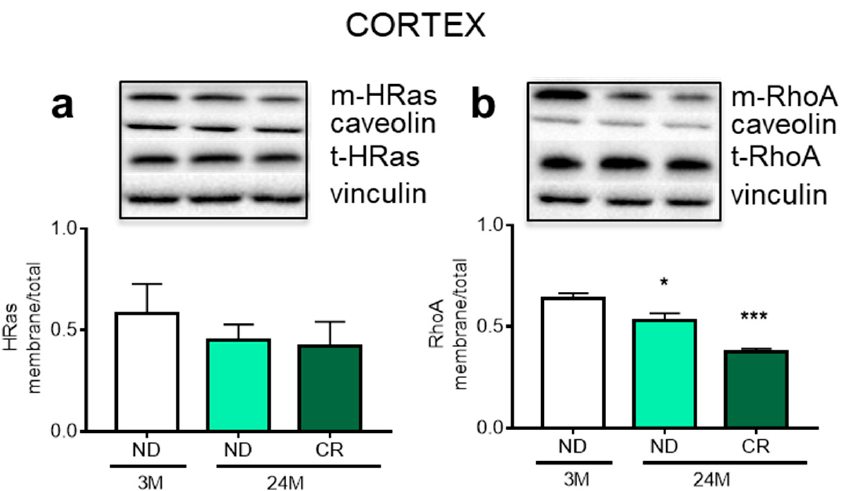
Figure 3. Impact of age and CR on membrane-bound and total levels of HRas and RhoA in rat cortex. Representative Western blots and densitometric analysis of membrane-bound (m-) and total content (t-) of HRas ( a ) and RhoA ( b ) in rat cortex. Vinculin and caveolin served as housekeeping proteins to normalize protein loading. 3M (3-month-old rats); 24M (24-month-old rats); ND (normal diet); CR (caloric intake reduced by 40% for the last 6 months of life). Statistical analysis was performed by using one-way ANOVA followed by Tukey’s post hoc test. * = p < 0.05, *** = p < 0.001, vs. 3M ND.